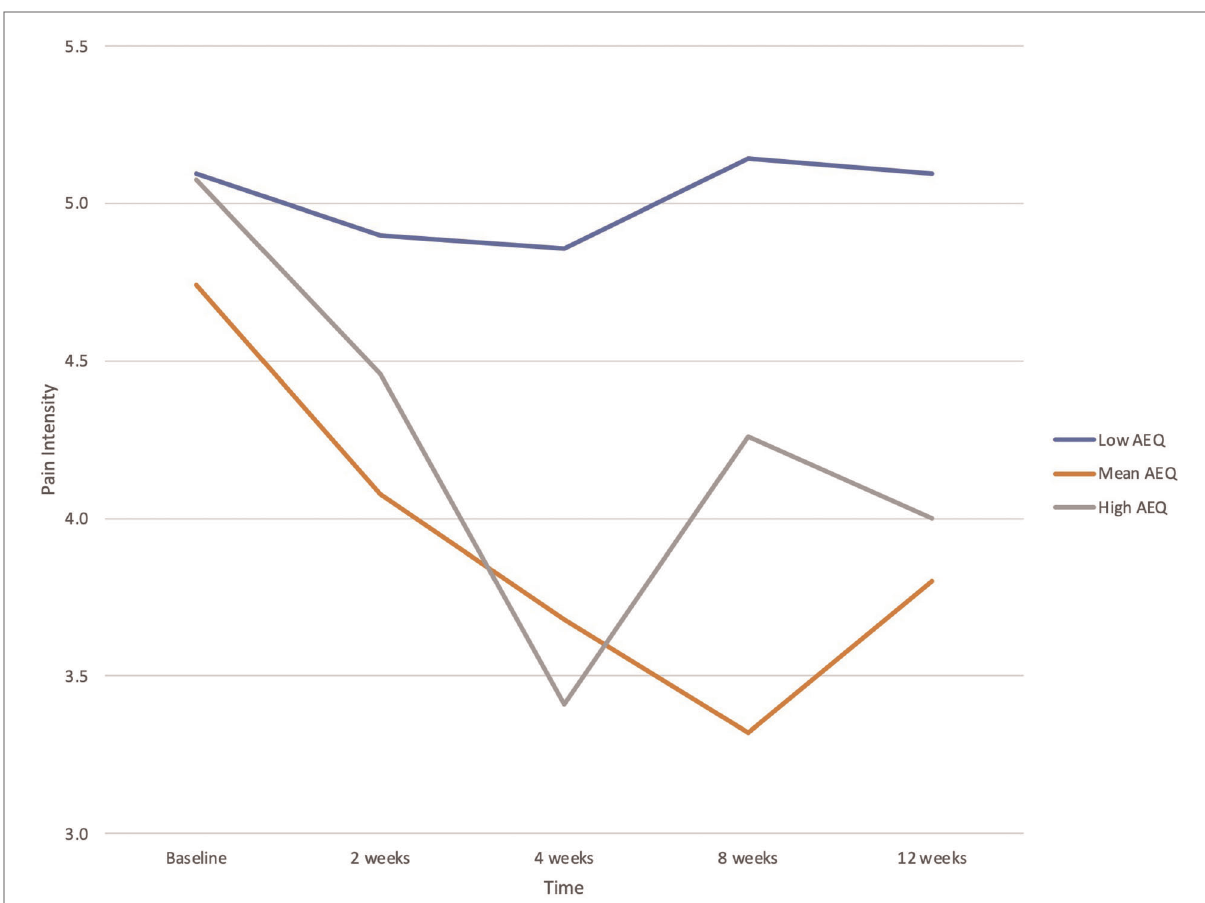
FIGURE 1 Baseline Ambivalence over Emotional Expression Questionnaire (AEQ) score as a predictor of changes in pain intensity from baseline (before the PSE class) through multiple follow-up assessments to 12 weeks. Plotted are low ( − 1 SD), mean, and high (+1 SD) values of